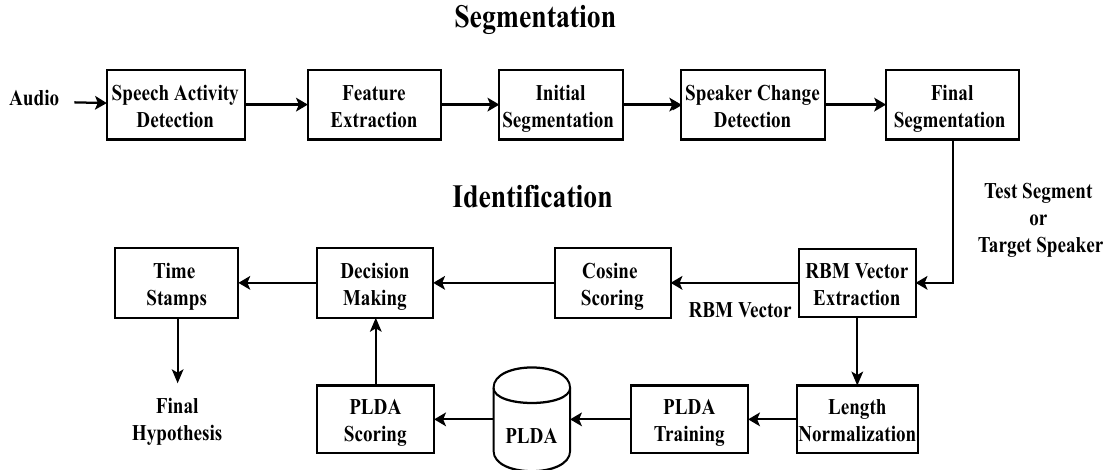
Figure 3. Architecture of Speaker Tracking using RBM vector